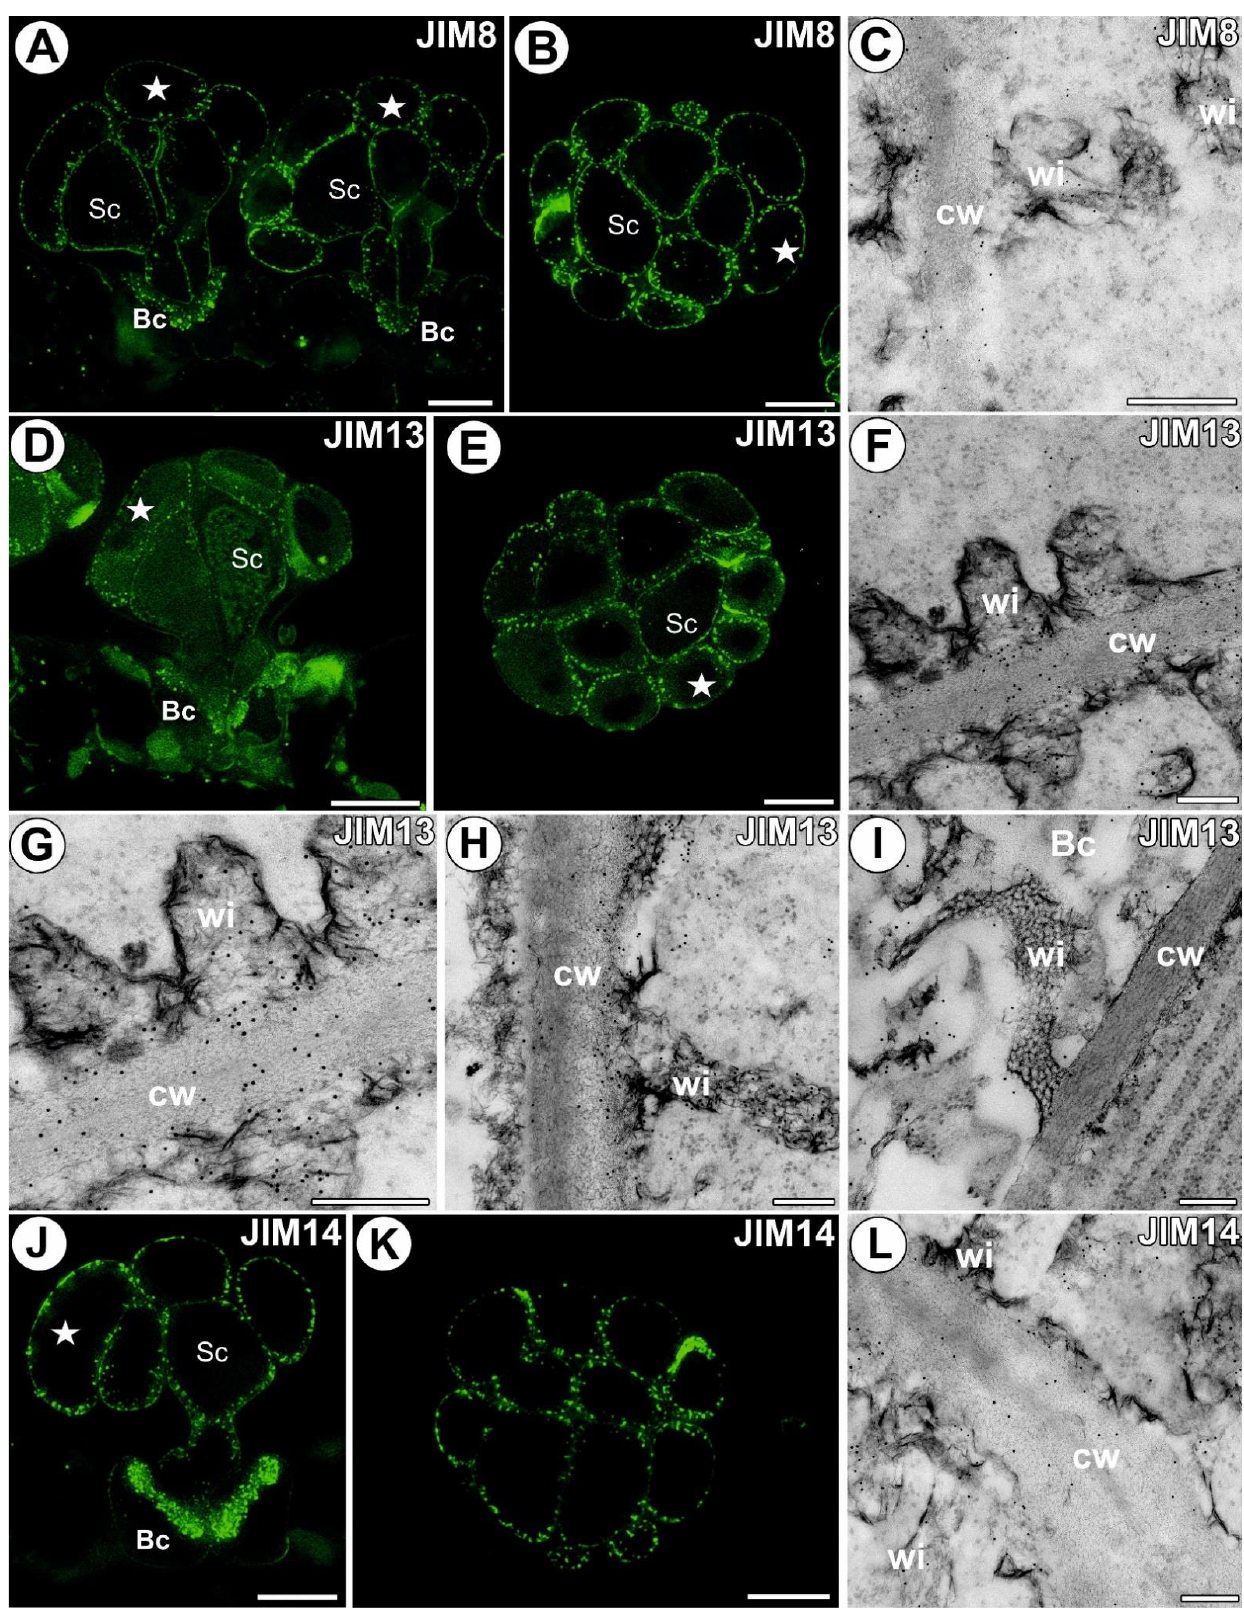
Figure 2. Arabinogalactan proteins detected in the A. vesiculosa trap. ( A ) Arabinogalactan proteins (labeled with JIM8) detected in the gland; secretory cell (star), stalk cell (Sc), basal cell (Bc), bar 10 µ m. ( B ) Arabinogalactan proteins (labeled with JIM8) detected in the gland, paradermal section; secretory cell (star), stalk cell (Sc), bar 10 µ m. ( C ) Immunogold labeling of wall ingrowths with JIM8 in the